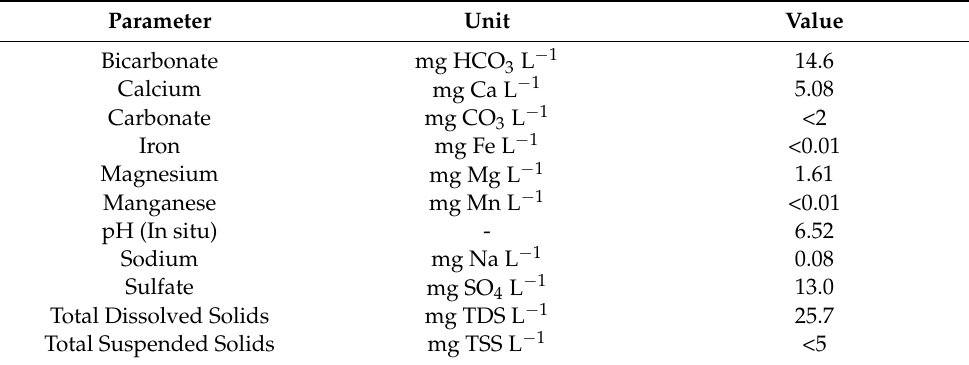
Table 2. Chemical characterization of irrigation